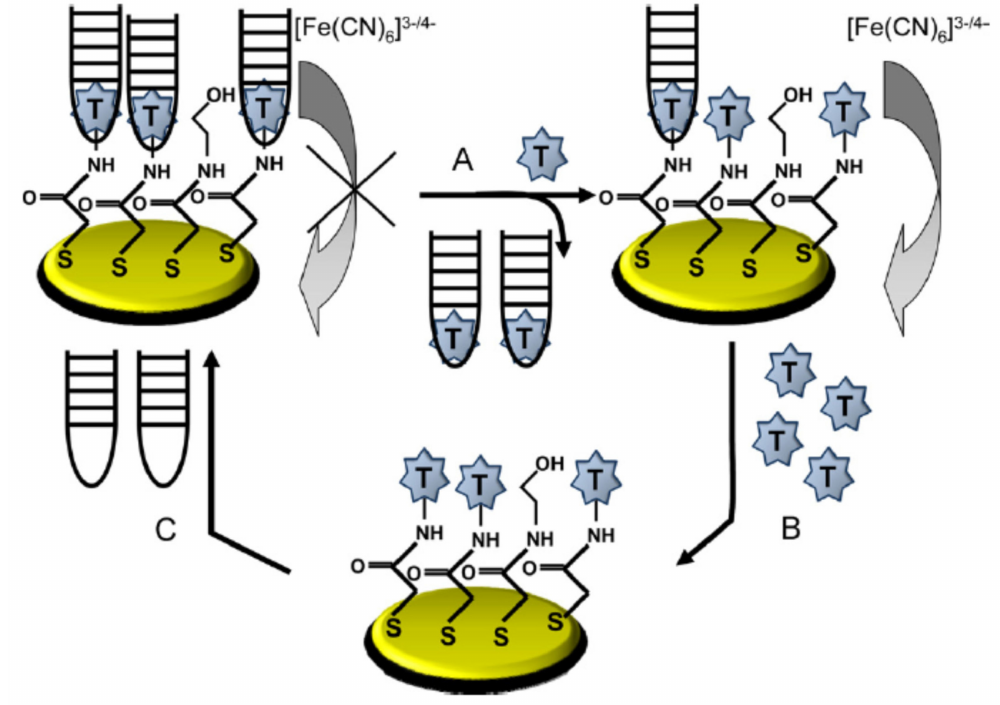
Figure 9. Working principle of an aptasensor based on aptamer displacement assay. ( A ) Incubation of tobramycin with the aptamer-modified electrode. ( B ) Sensing phase regeneration. ( C ) Saturation of the sensing phase with the aptamer. Reprinted from reference [19] with permission from